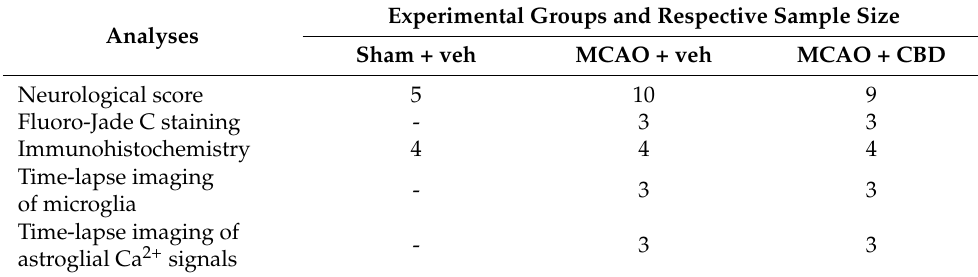
Table 1. Sample size according to experimental groups and